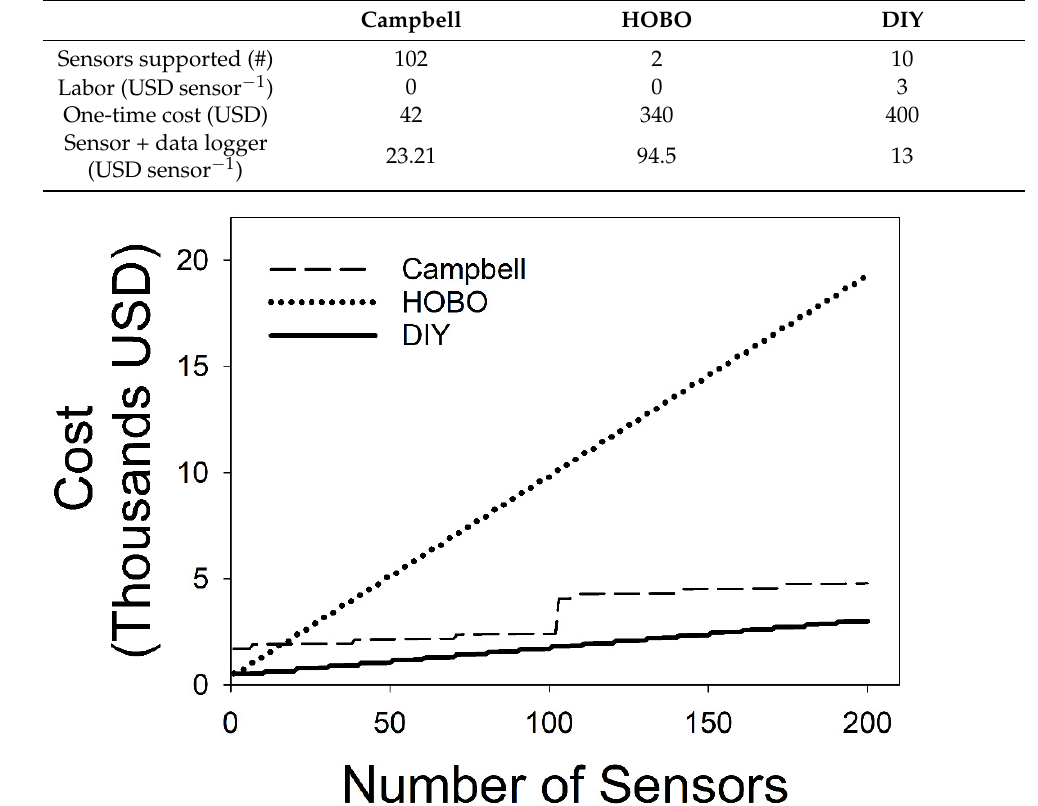
Figure 3. A plot of the cost of supporting 1–200 sensors for HOBO, Campbell, and the DIY soil temperature data temperature data logger. Table 2. Cost of three soil temperature data logger systems including our DIY soil temperature data logger setup in their most efficient configurations. One-time costs refer to reusable manufacturing tools, data transfer cables, and proprietary software.